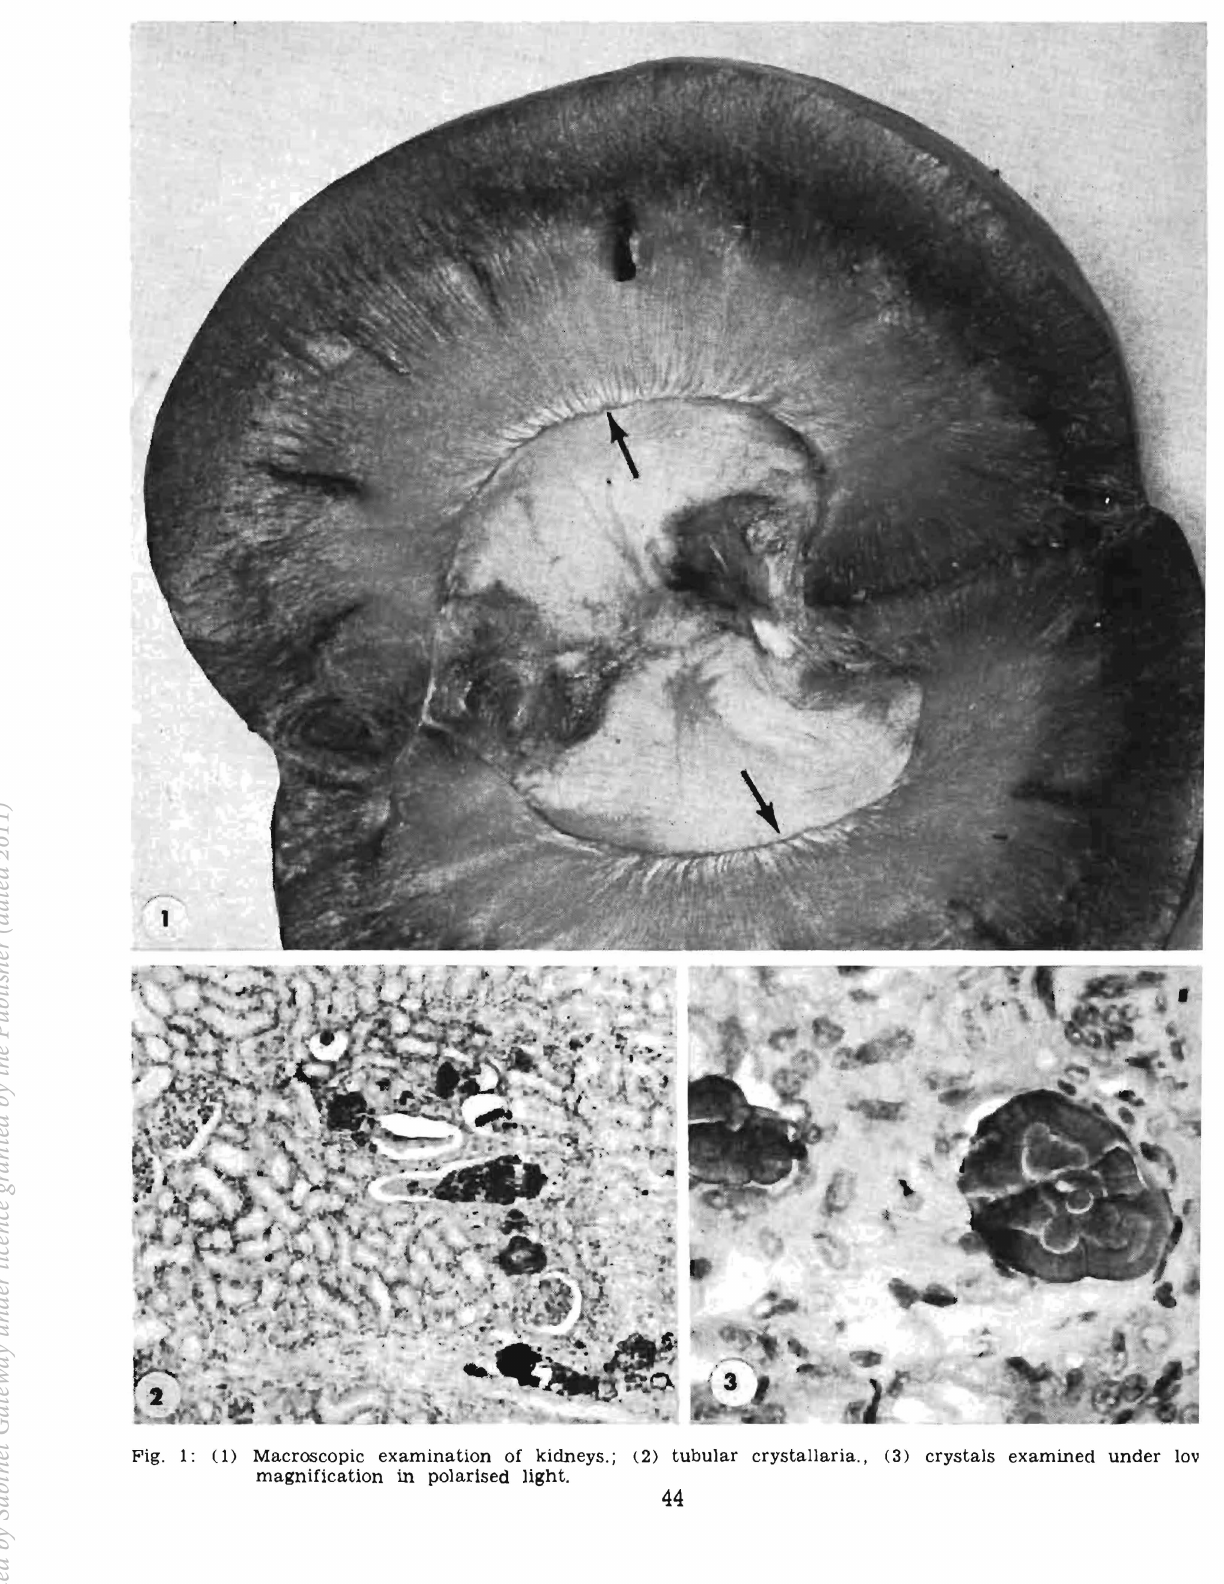
Fig. 1: (1) Macroscopic examination of kidneys.; (2) tubular crystallaria., (3) crystals examined under lov magnification in polarised light.